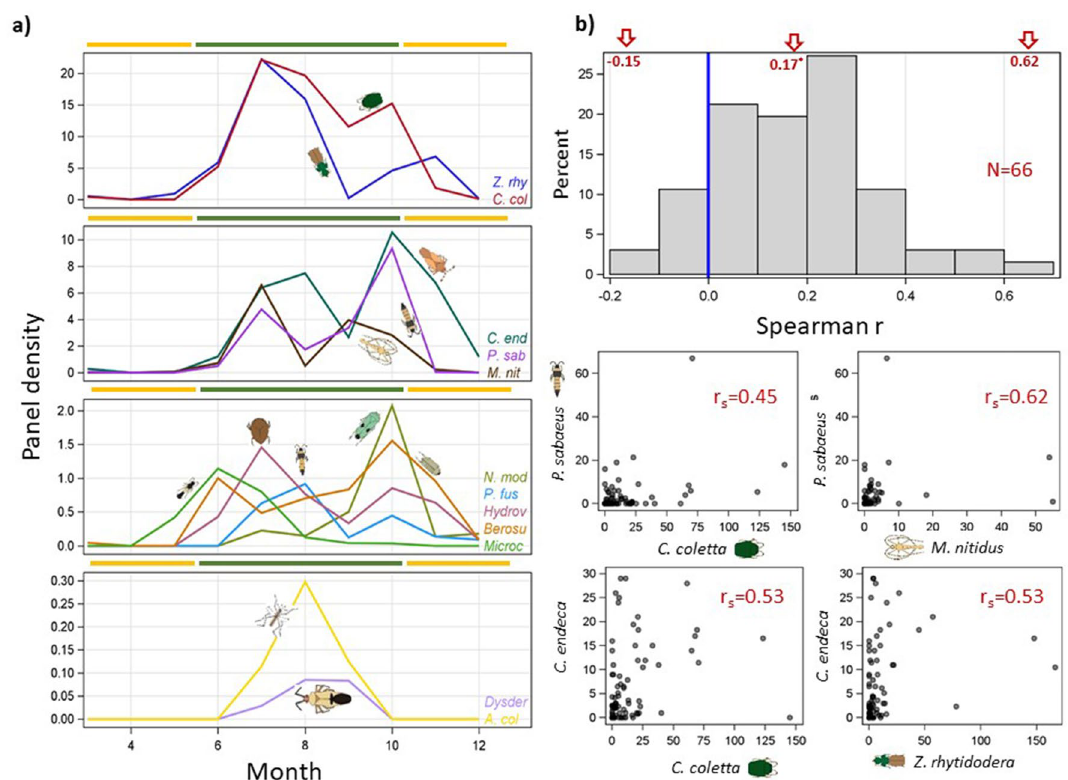
Figure 3. Temporal variation in flight activity across taxa. ( a ) Seasonal variation of migrant insects measured by panel density based on three-year data. Dry and rainy season are shown by yellow and green colors (ruler). ( b ) The distribution of the Spearman correlation coefficient (r s ) between 66 pairs of migrant insects and relationship in nightly mean densities of the taxa pairs with highest Spearman correlation coefficients (b, N = 96 nights). Schematic insect silhouettes are not to scale (species names are truncated to conserve